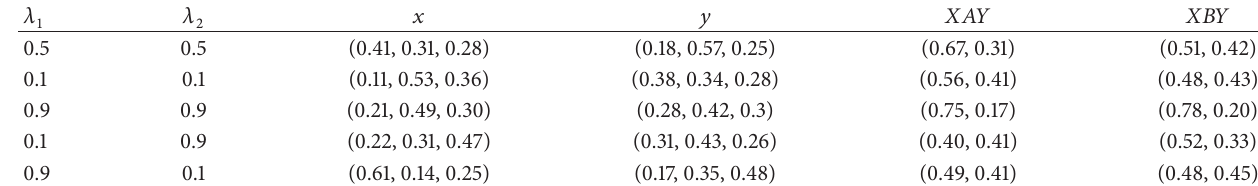
Table 1: The solution and expectation of satisfaction degree and reject